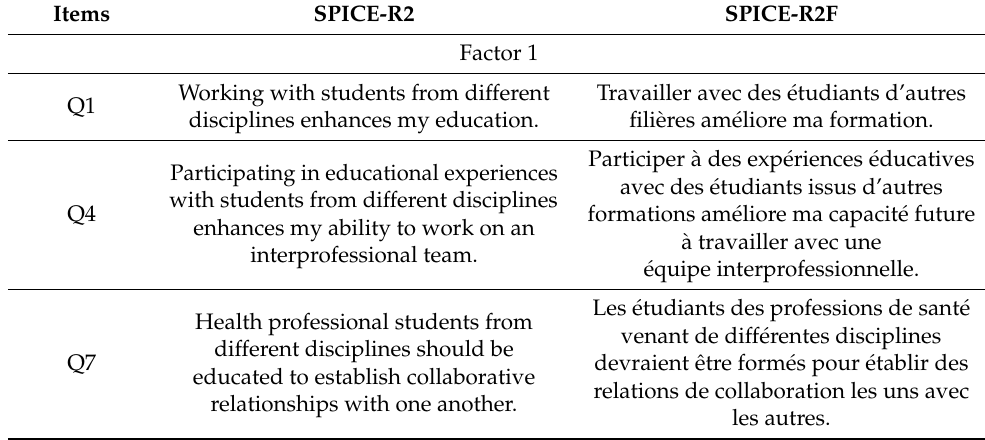
Table 1. Comparison of the English (SPICE-R2) and French (SPICE-R2F) instruments. The elements ap- pear in the order of the proposed factors: teamwork and team practice (factor 1), roles/responsibilities for collaborative practice (factor 2), and patient outcomes of collaborative practice (factor 3). In the survey, the items appeared chronologically according to their item number as presented in column